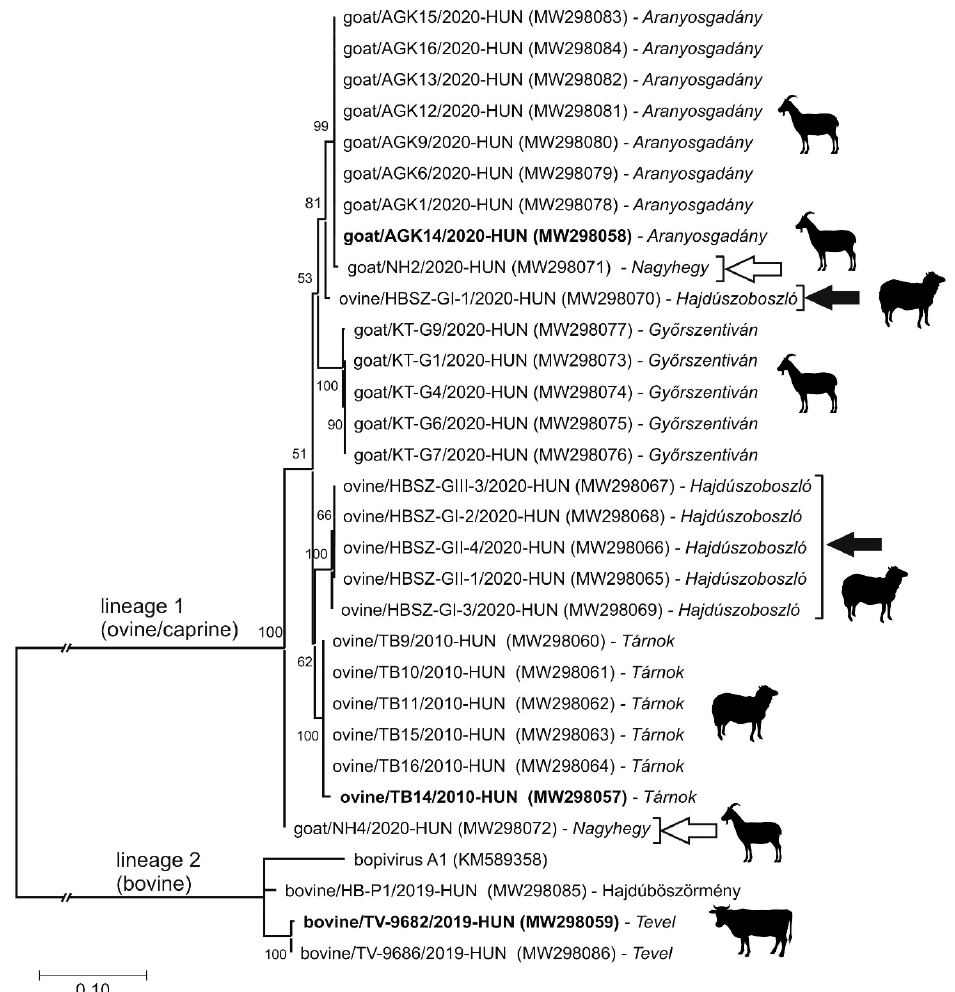
Figure 6. Phylogenetic analysis of determined bopivirus 3D RdRp sequences. The tree was constructed with the Maximum Likelihood method and Jukes-Cantor model. The percentage of trees in which the associated taxa clustered together (bootstrap) is shown (where values are >50) next to the branches. The trees are drawn to scale, with branch lengths measured in the number of substitutions per site. The origin (farm location) and silhouettes of the samples’ hosts are found after the strain names. The locations of lineage 1 of ovine/caprine and lineage 2 of bovine bopiviruses are also indicated. Black and empty arrows indicate the phylogenetic positions of different caprine (empty arrows) and ovine (black arrows) lineages originated from the same farm. The ovipi-, gopi- and bopi-virus/Hun sequences are marked in bold